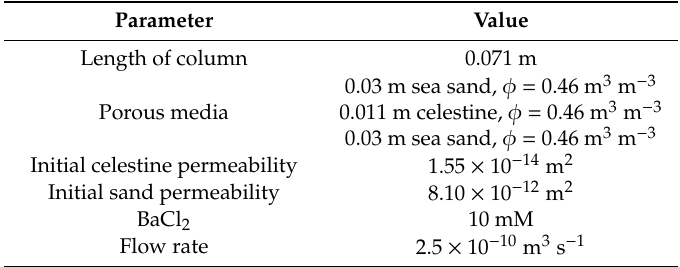
Table 1. Summary of experimental